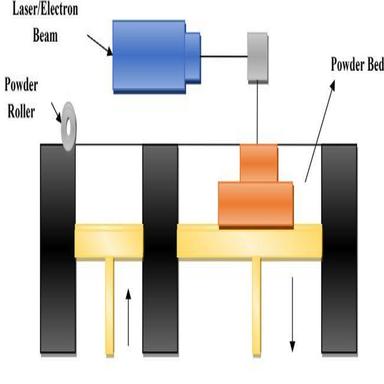
Schematic diagram of inkjet printing.